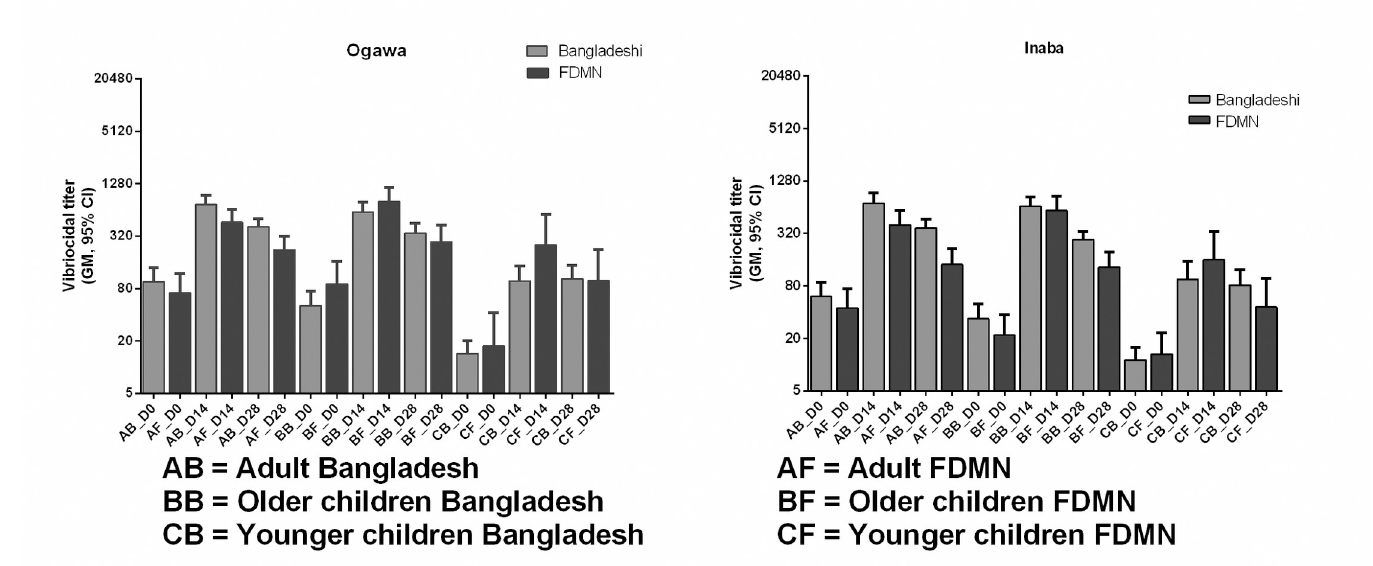
Fig 7. Comparison of vibriocidal antibody responses between FDMN and Bangladeshi population in adults, older children and younger children.